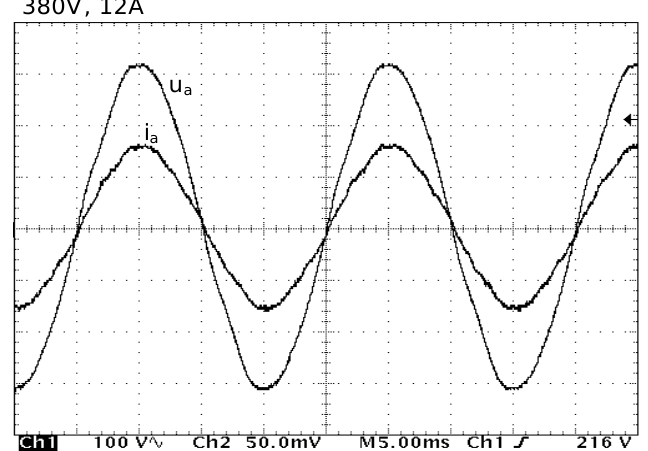
Figure 22. Oscillograms: Line voltage u a and current i a waveforms of the 2 kW rectifier.